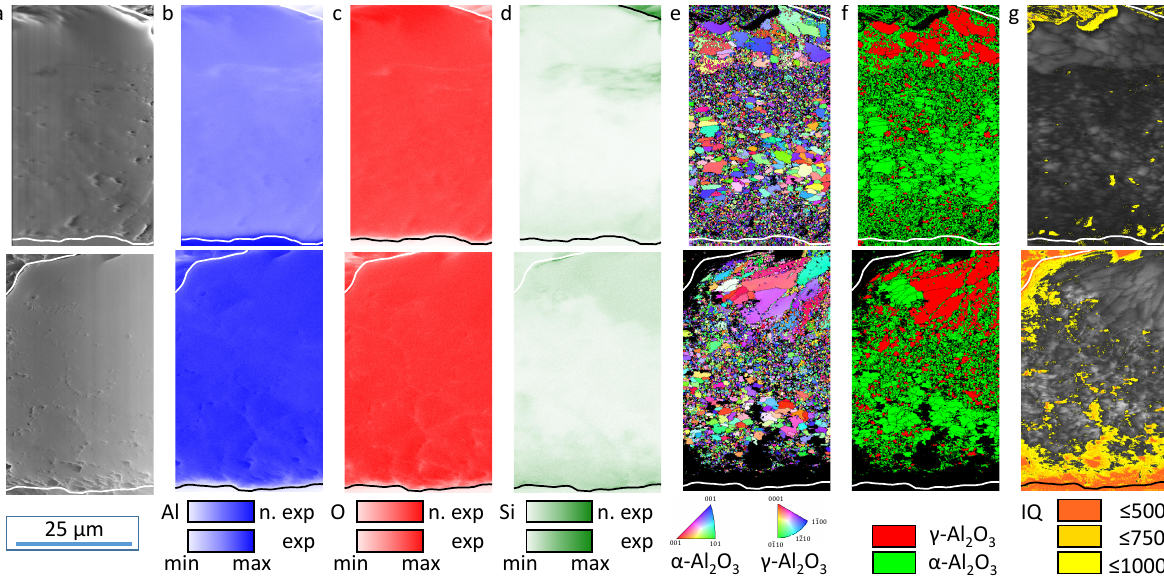
Figure 12. SEM ( a ) image as well as EDX ( b – d ) and EBSD ( e – g ) maps for the cross-section of a sample exposed to electrolyte III at unaffected (top) and affected (bottom) surface regions (Pos. 1 and 2 in Figure